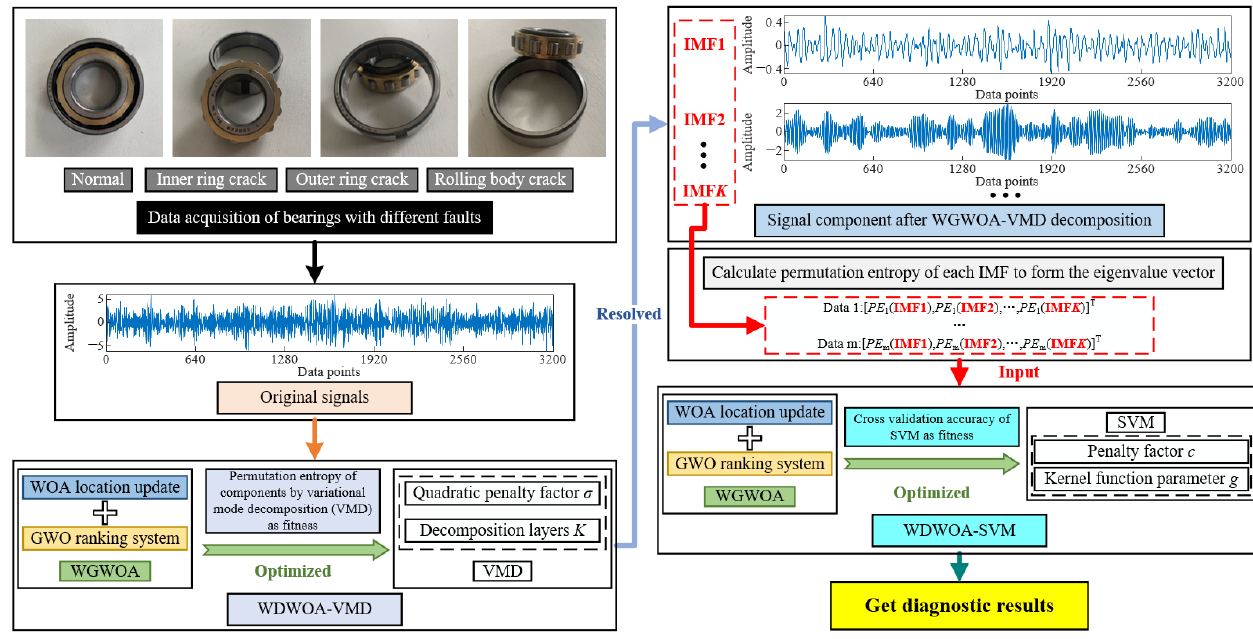
8 of 27 Figure 2. Flowchart of fault diagnosis based on the optimized SVM. 3. Fault Diagnosis of Rolling Bearing Based on WGWOA-VMD-SVM